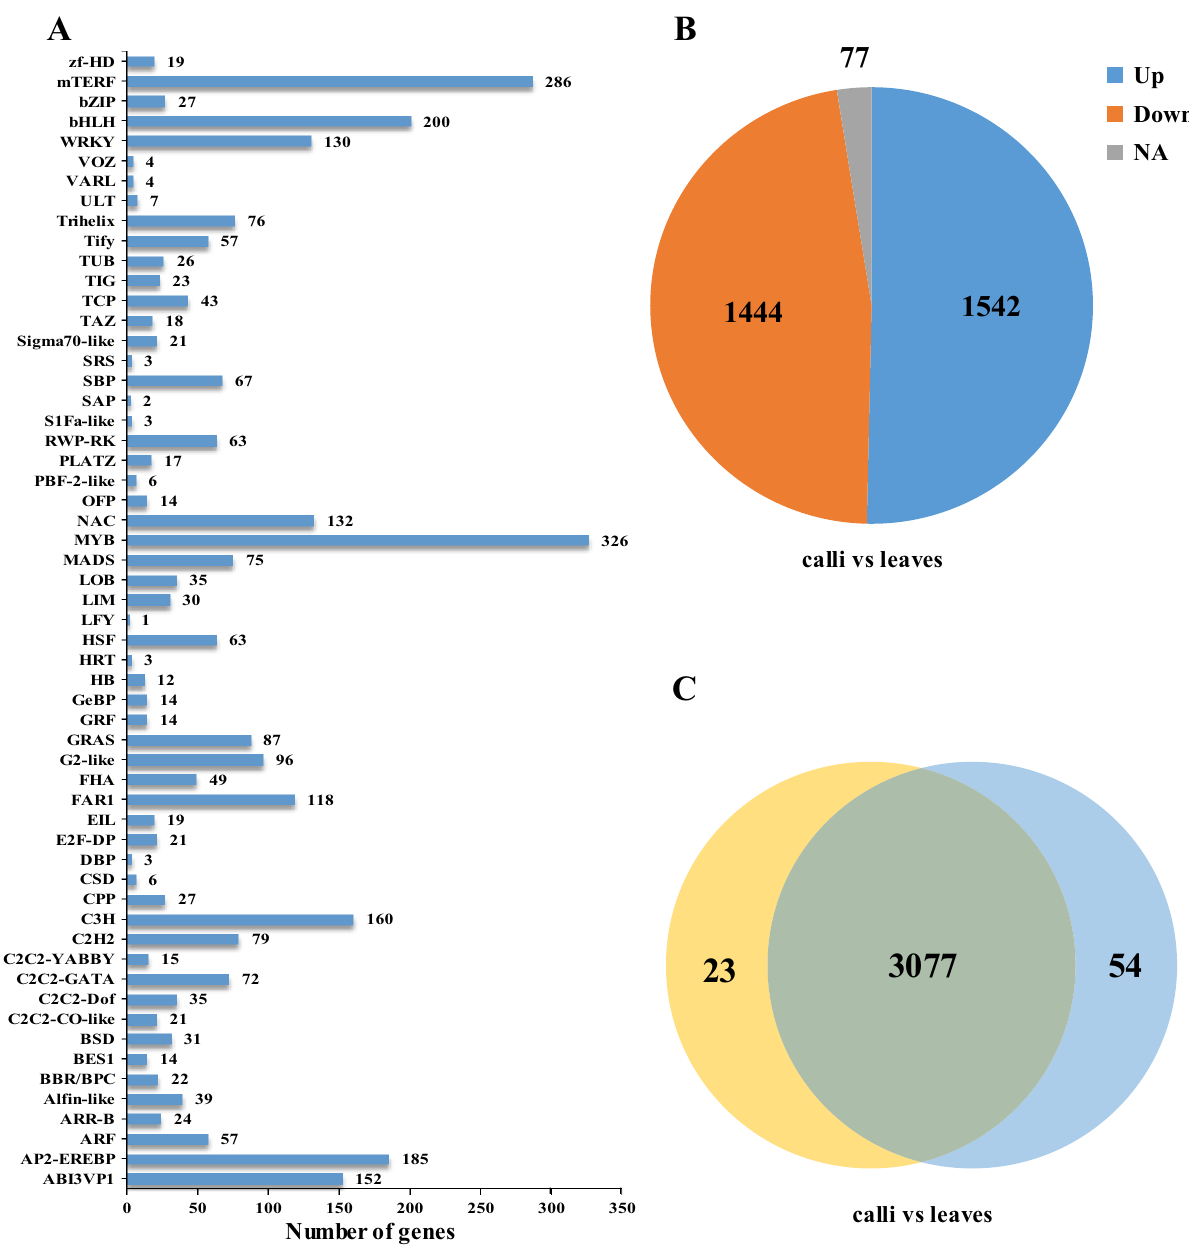
Figure 7. Transcription factors (TFs) expression analysis. ( A ) Classification of gene transcription factors’ family. ( B ) The expression level of TFs gene is different in calli vs. leaves, NA stands for expression only in calli or leaves. ( C ) Venn diagram of TFs gene expression in leaves and